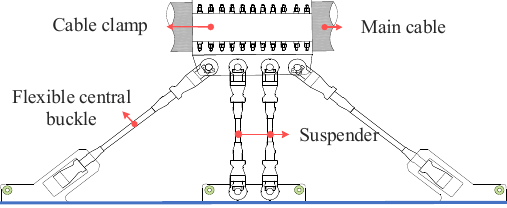
Figure 3. Flexible central buckle.